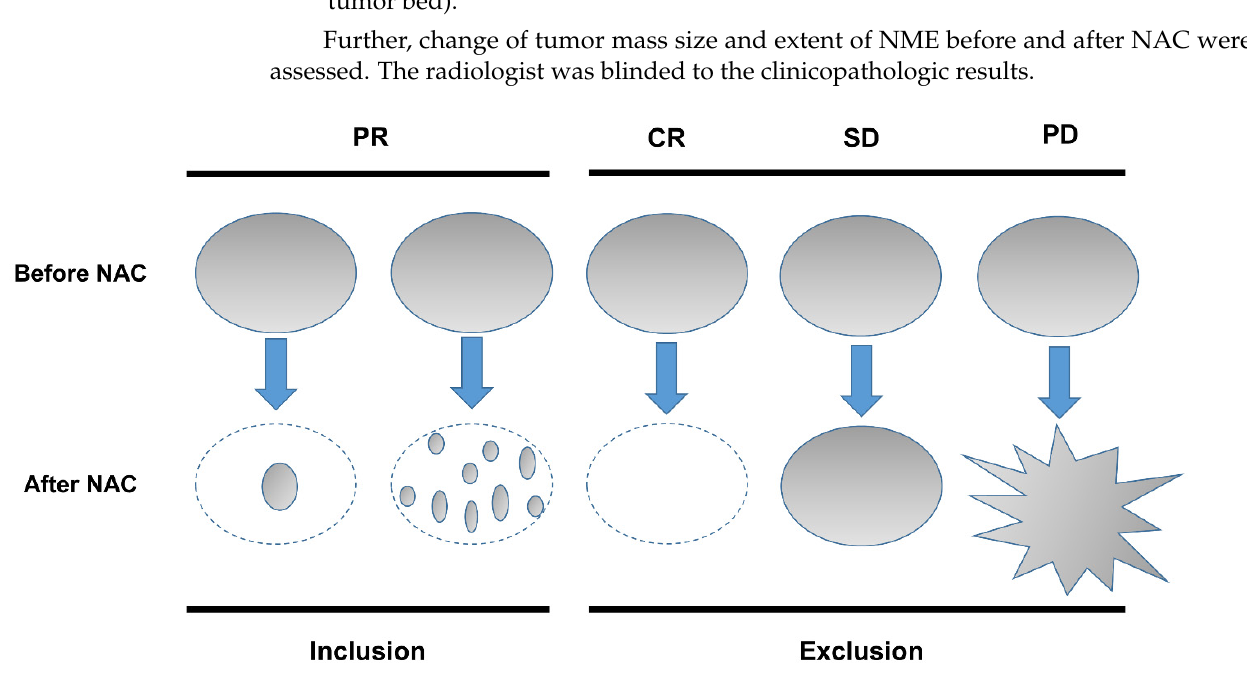
Figure 2. Magnetic resonance imaging (MRI)-based response patterns of breast tumors on breast MRI before and after neoadjuvant chemotherapy. PR, partial response; CR, complete response; SD, stable disease; PD, progressive disease; NAC, neoadjuvant chemotherapy.